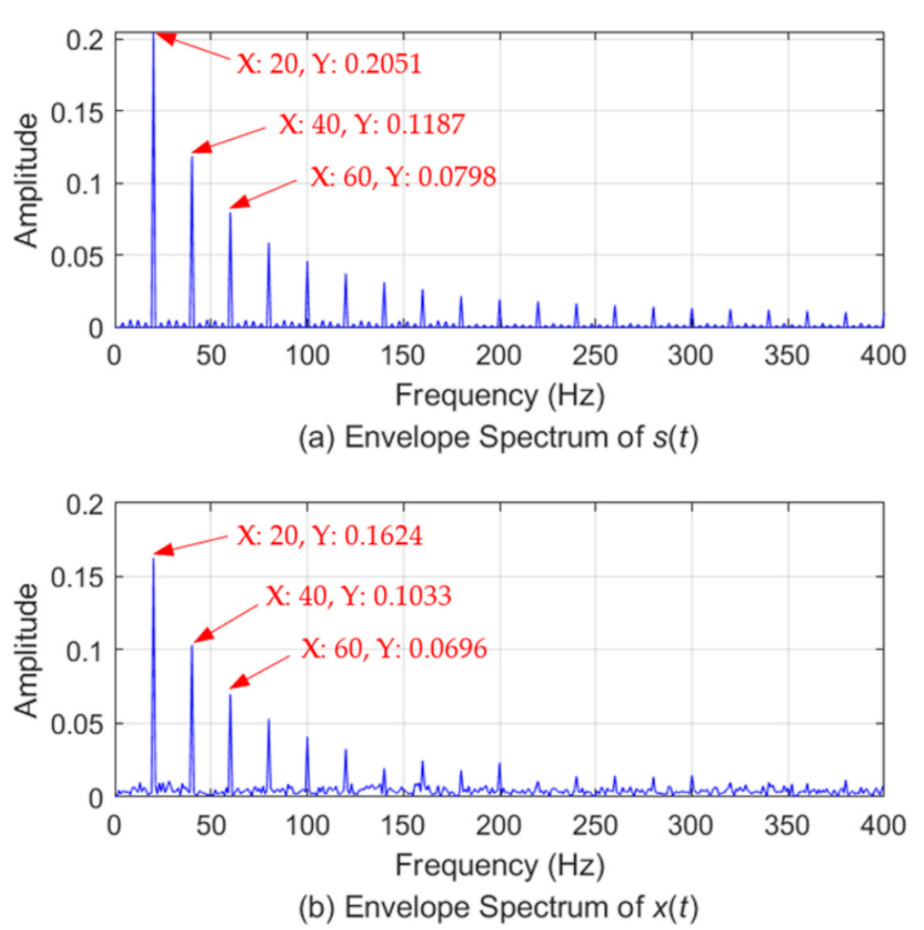
Figure 4. Envelope spectra of experimental signals s ( t ) and x ( t ).